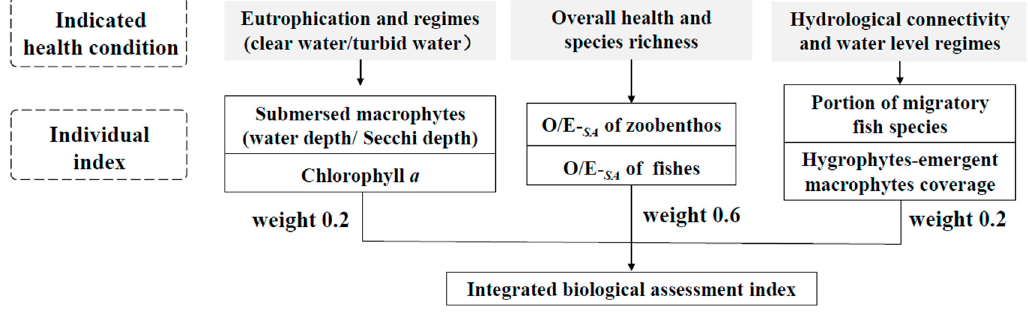
Figure 6. An integrated biological assessment index for Yangtze-disconnected floodplain lakes.